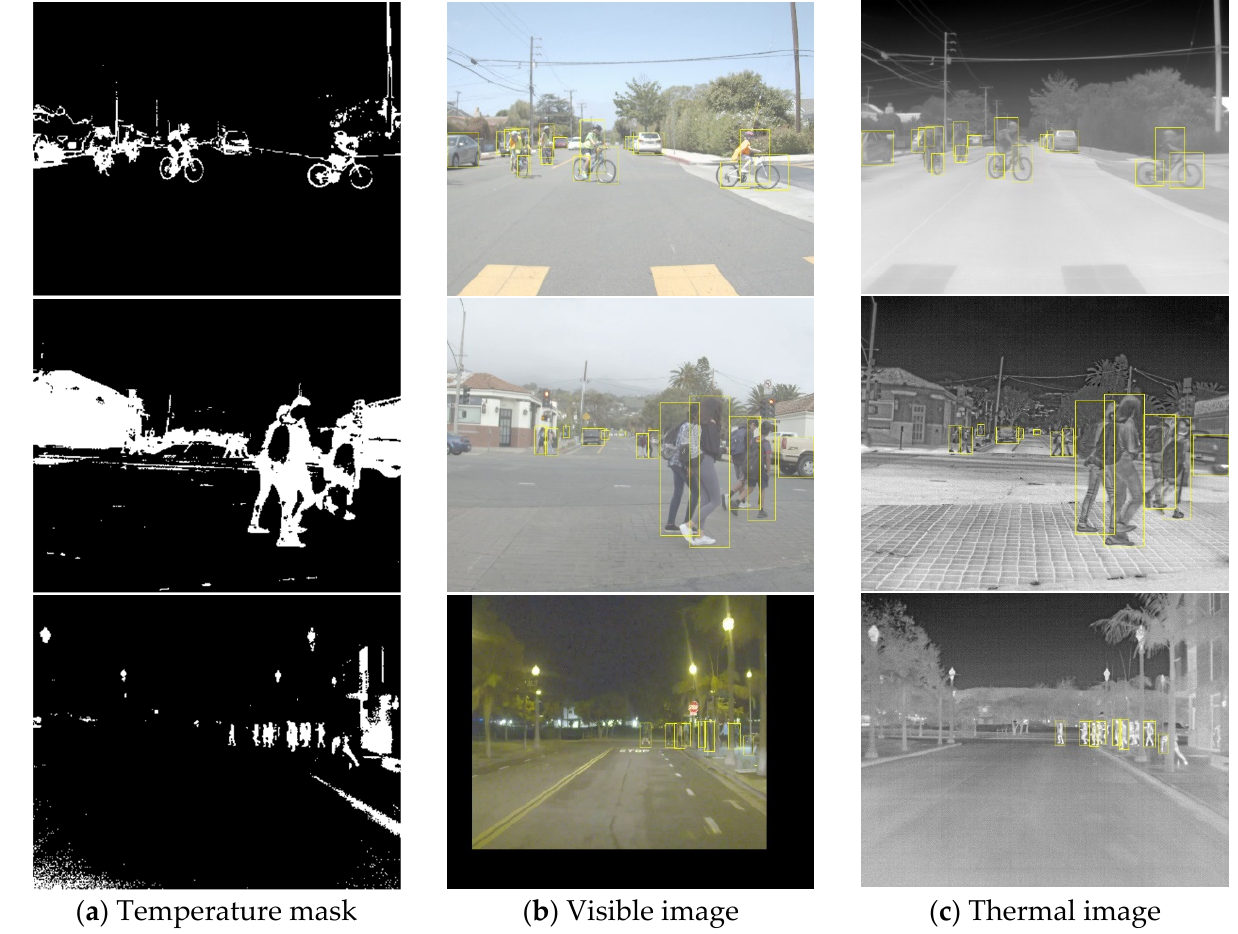
Figure 3. The temperature masks in different illumination conditions (sunny day, cloudy day and night).